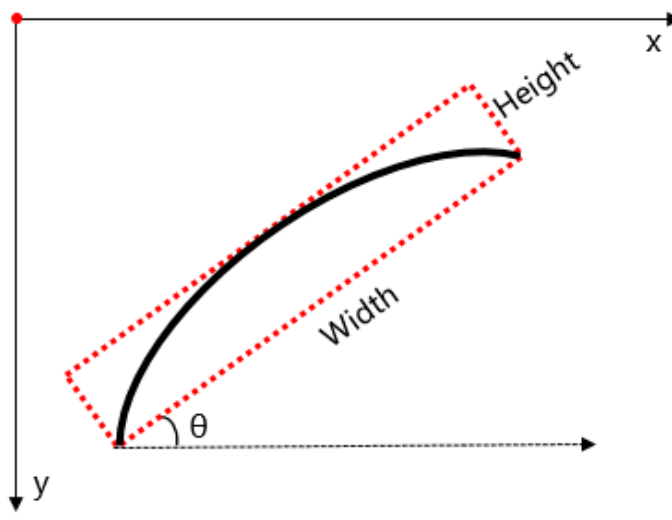
Figure 11. Schematic diagram of minimum circumscribed rectangle. where θ is the included angle between the counterclockwise rotation of the horizontal axis and the first side of the encountered rectangle. The side length is width, and the top and bottom sides are height. The thinned image is I 1 , imgW and imgH are the width and height of the original image, W and H are the width and height of the minimum circumscribed rectangle, T represents the width–height ratio of the minimum circumscribed rectangle, the length is L, and S represents the area.